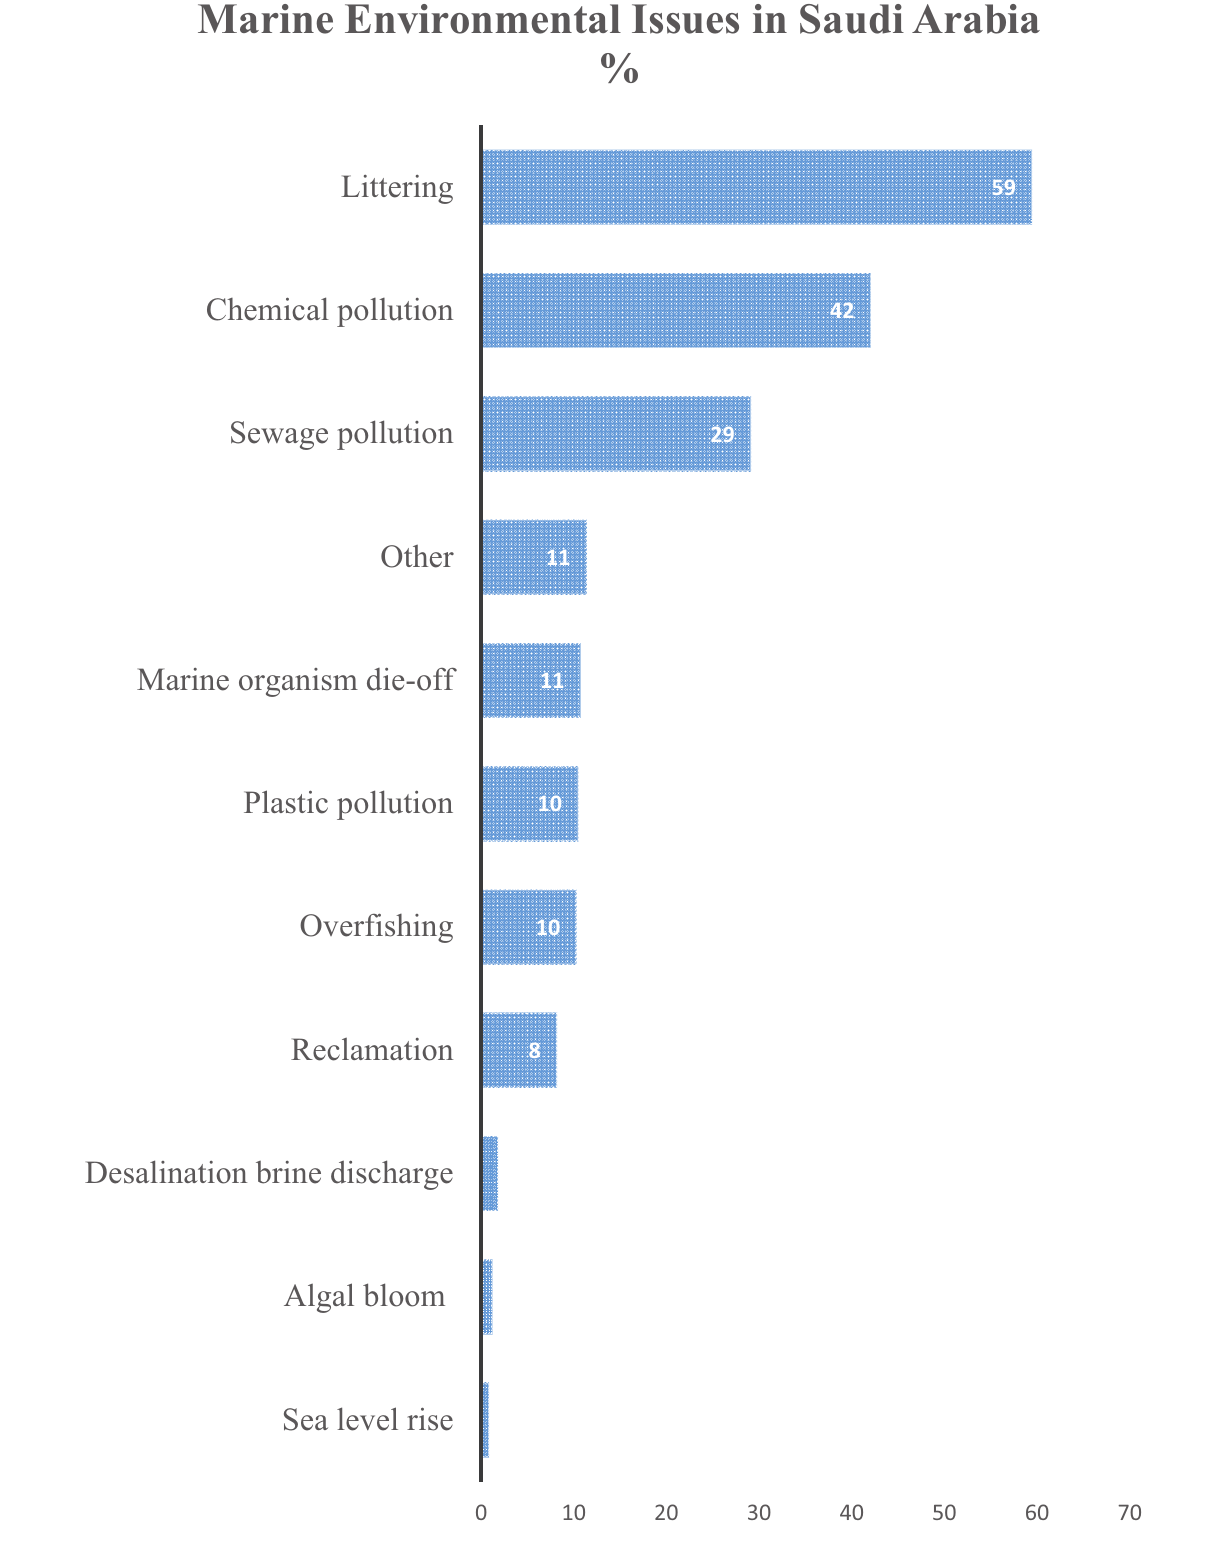
FIGURE 8 | Responses to the question: When you think about the coastline or the sea, what are the three most important marine environmental issues that come to mind in Saudi Arabia?